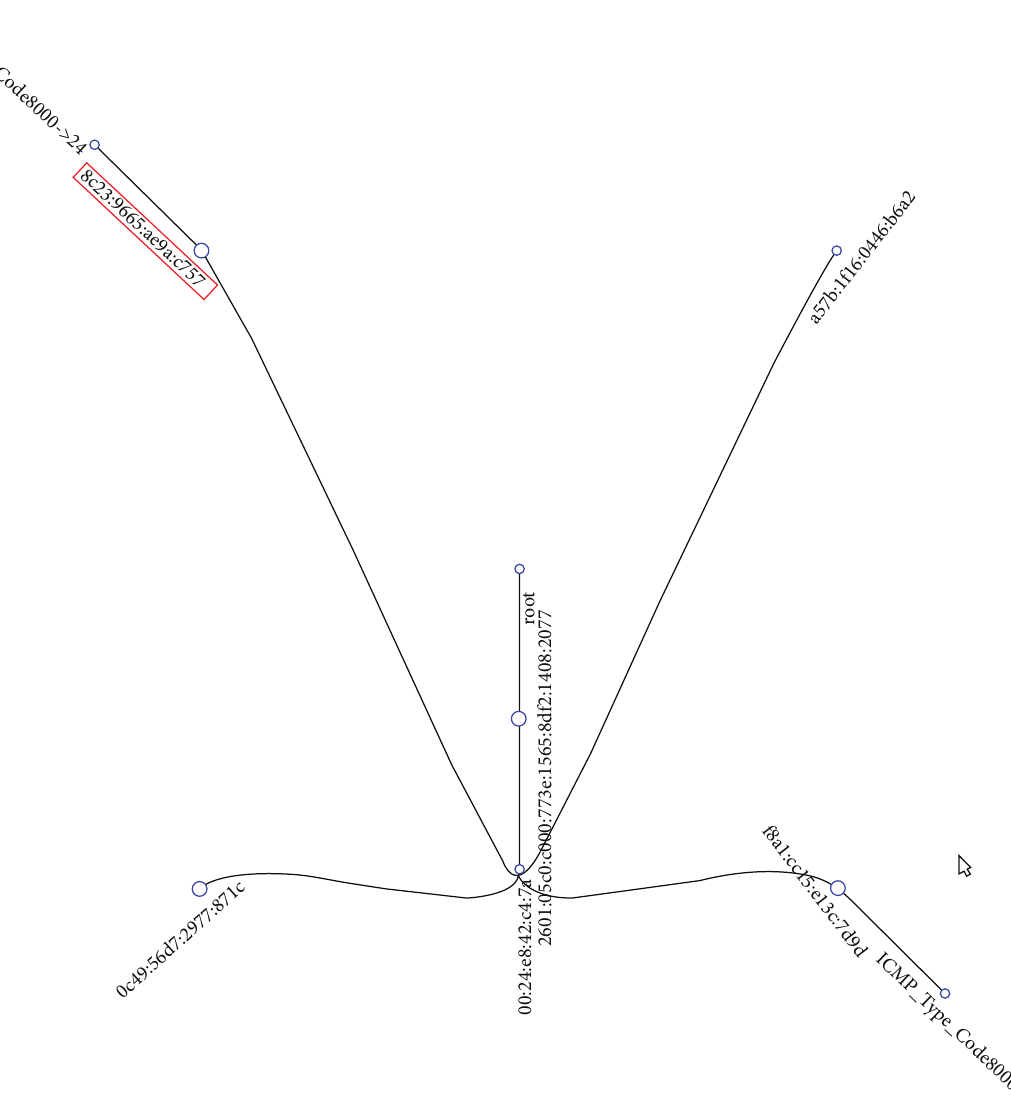
Figure 7: MT6D view of incoming traffic hitting the CN